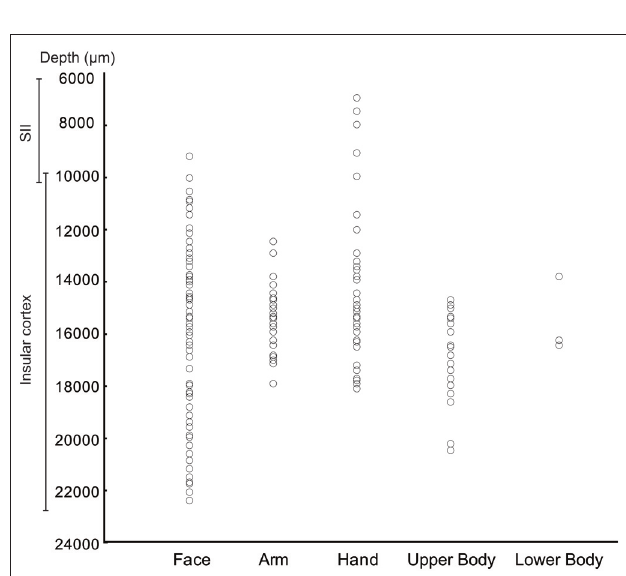
FIGURE 7 | Distribution of the task related neurons in relation to the localization of